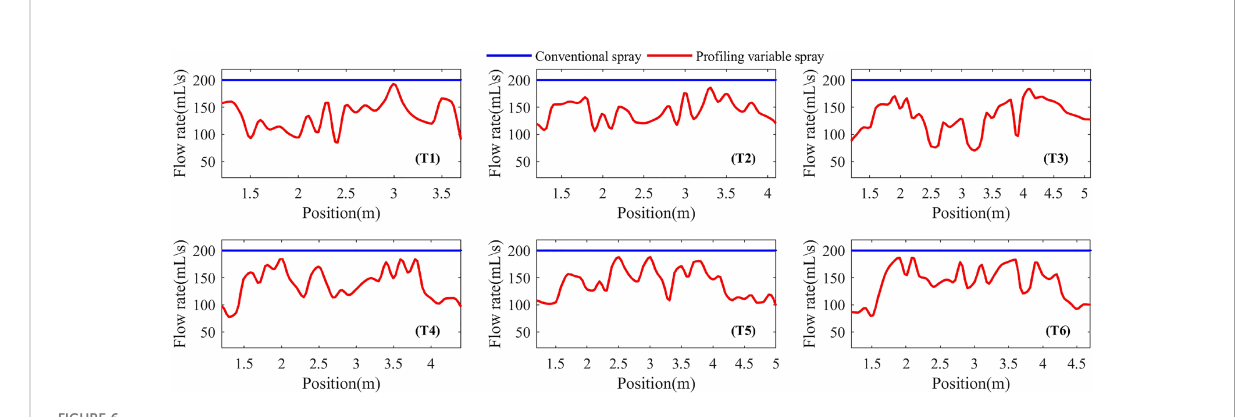
FIGURE 6 Spray fl ow rate in different spray methods for Tree T1~T6